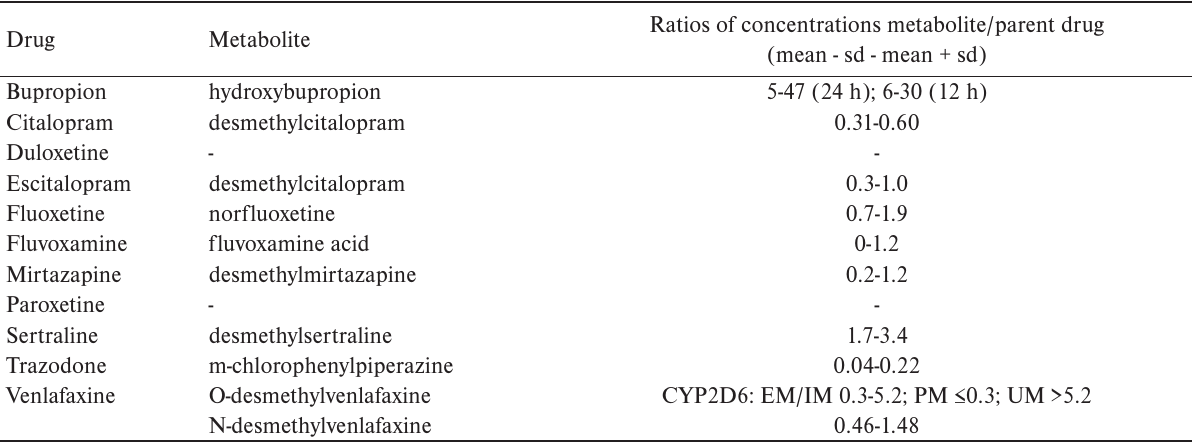
Table 6. Ranges of metabolite-to-parent drug concentration ratios 9